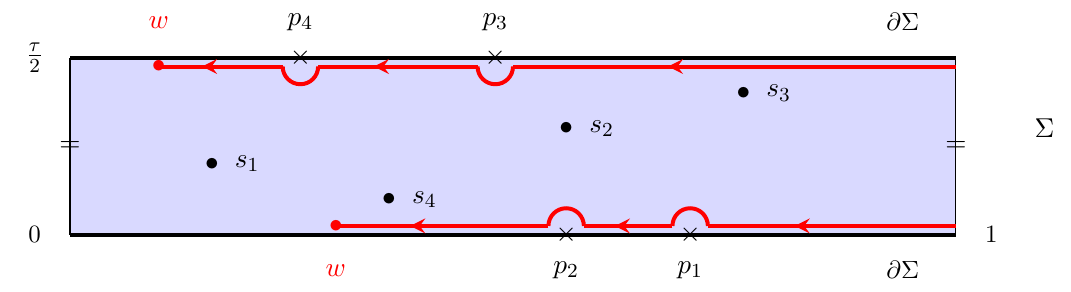
Figure 8 . The annulus (cid:6) is represented as in (cid:12)gure 7. The contours of integration along the upper and lower boundary components of @ (cid:6) are indicated with thick red